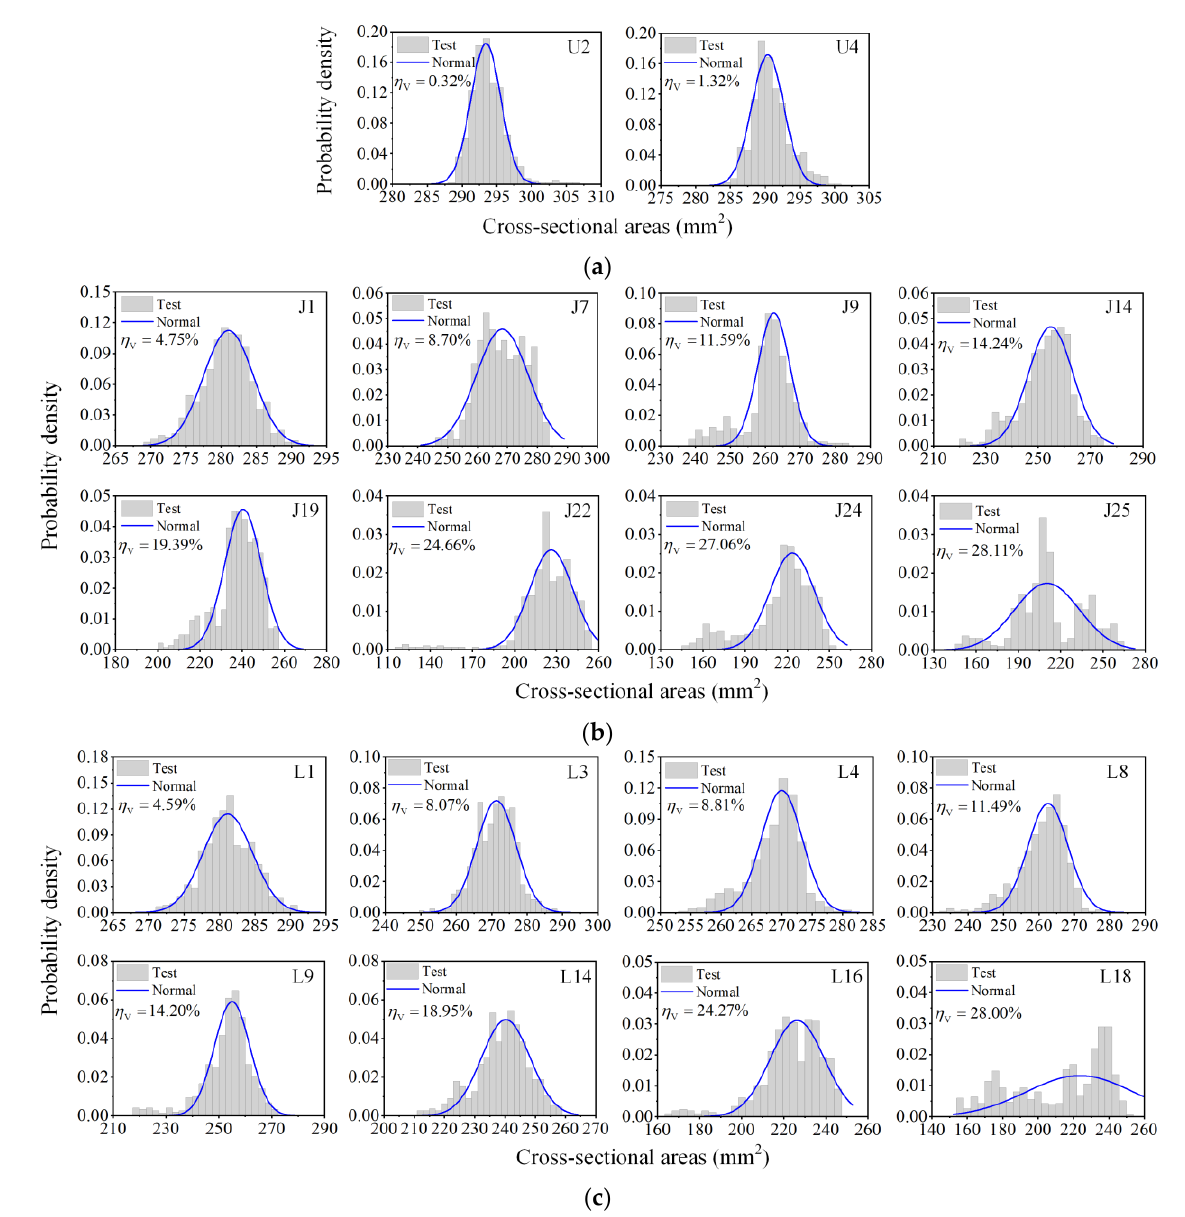
Figure 8. Probability distribution of cross-sectional areas: ( a ) uncorroded rebars; ( b ) rebars from intact slab; ( c ) rebars from pre-cracked slab.